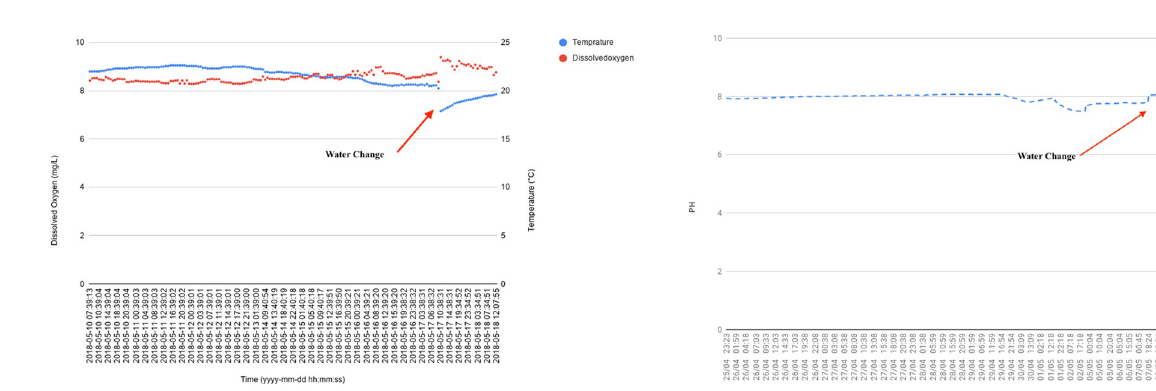
Fig. 11 Temperature and dissolved oxygen data for the Kob experi-